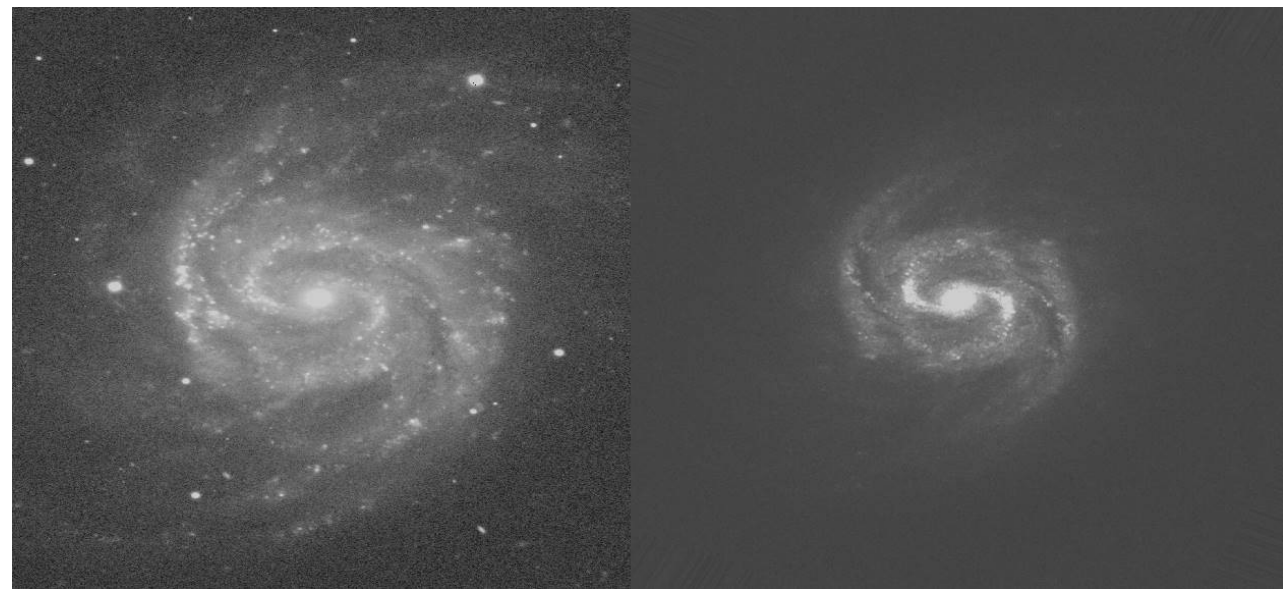
Figure 6. m = 2 symmetrical component of galaxy NGC 1042. ( Left ) Original B -band image. ( Right ) Symmetrical-component image. Foreground stars and asymmetric bright features are re- moved and symmetrical features remain, allowing for more accurate measurement of spiral-arm pitch angles. Taking symmetrical components, where applicable, is a more rapid process for improving measurement than other methods, such as star subtraction. However, this comes at a cost of loss of information about the galaxy, as arm segments which do not fit the symmetry of the selected symmetrical component are